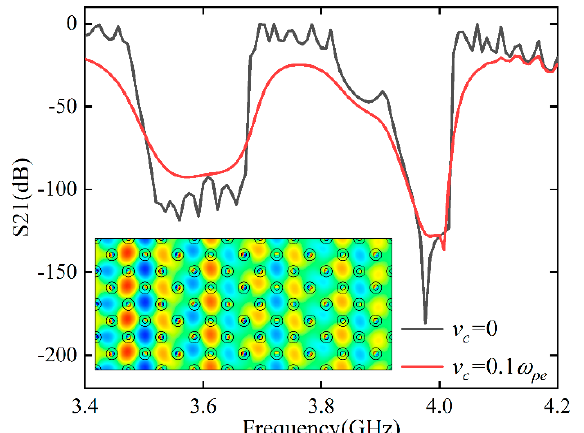
Figure 3. Transmission spectra of the PPC for the TM mode considering a collision frequency of ν c = 0.1 ω pe .